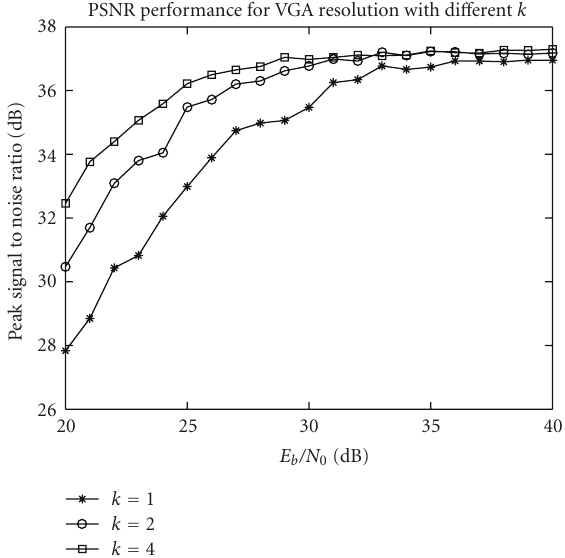
Figure 16: The PSNR performance for VGA resolution with di ff erent space ratio k . The priority of each data packet is labeled and aware of by the MAC